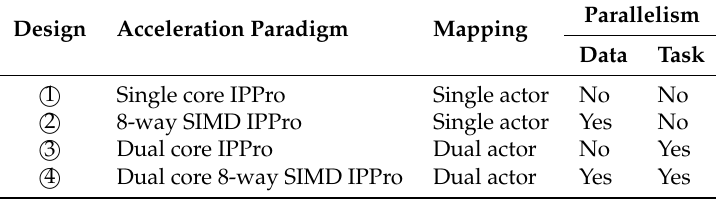
Table 6. Dataflow actor mapping and supported parallelism of IPPro hardware accelerator design presented in Figure